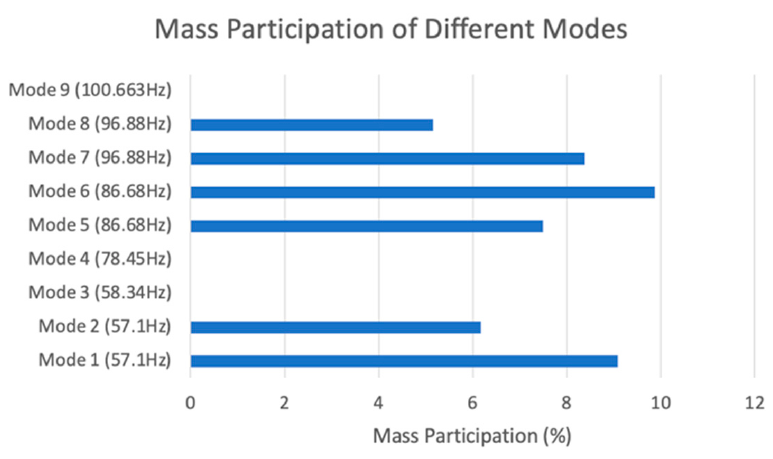
Figure 17. Mass participation of different modes.